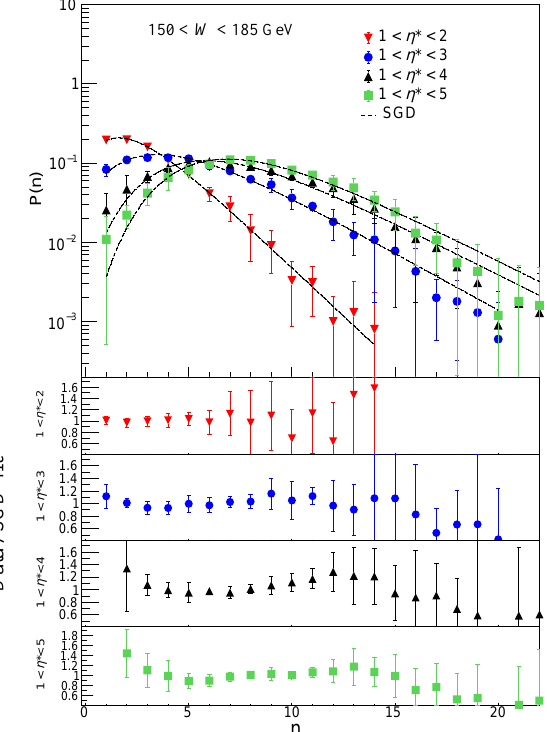
Figure 4. Multiplicity distributions for SGD fits to the data [33] in different η ∗ ranges for 150 < W < 185 GeV. The lower panel shows the data/SGD-fit ratio plots for different η ∗ regions.